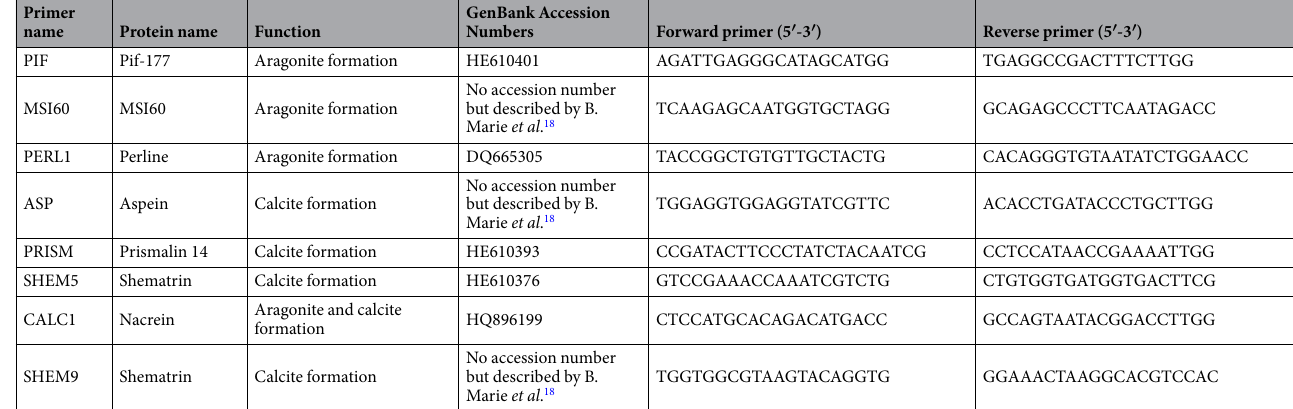
Table 2. Set of forward and reverse primers used for the biomineralisation gene expression analysis in Pinctada margaritifera